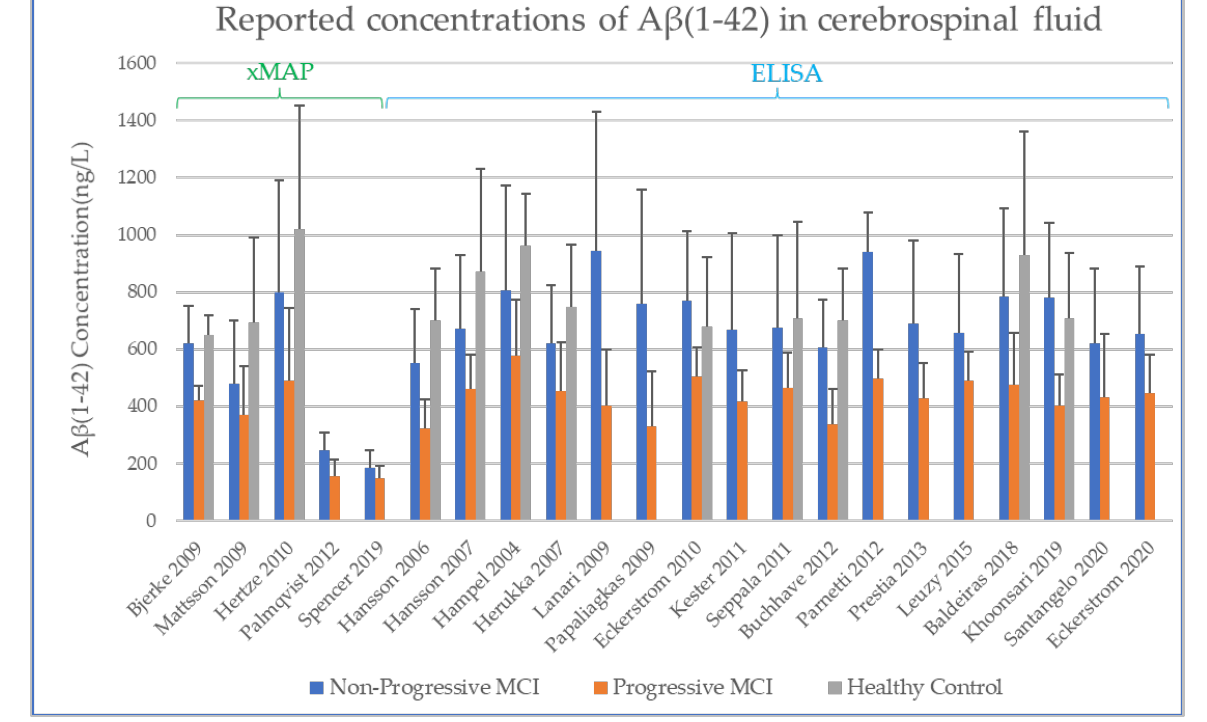
Figure 3. Concentration of amyloid beta 1-42 in CSF at baseline, as determined by xMAP and ELISA.